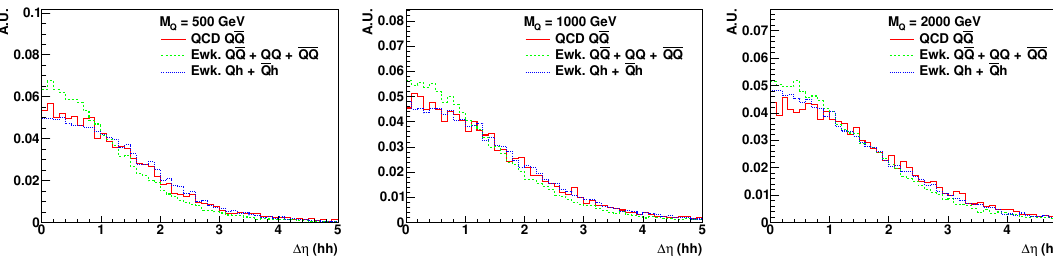
Figure 9 . Same as (cid:12)gure 8 but for the transverse momentum of the di-Higgs system.